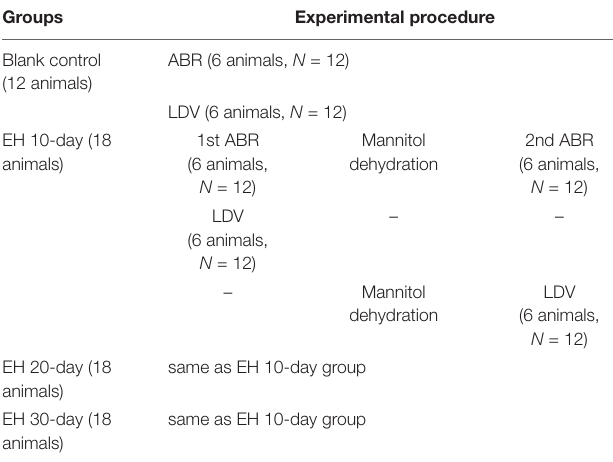
TABLE 1 | A flowchart of the experimental procedure.